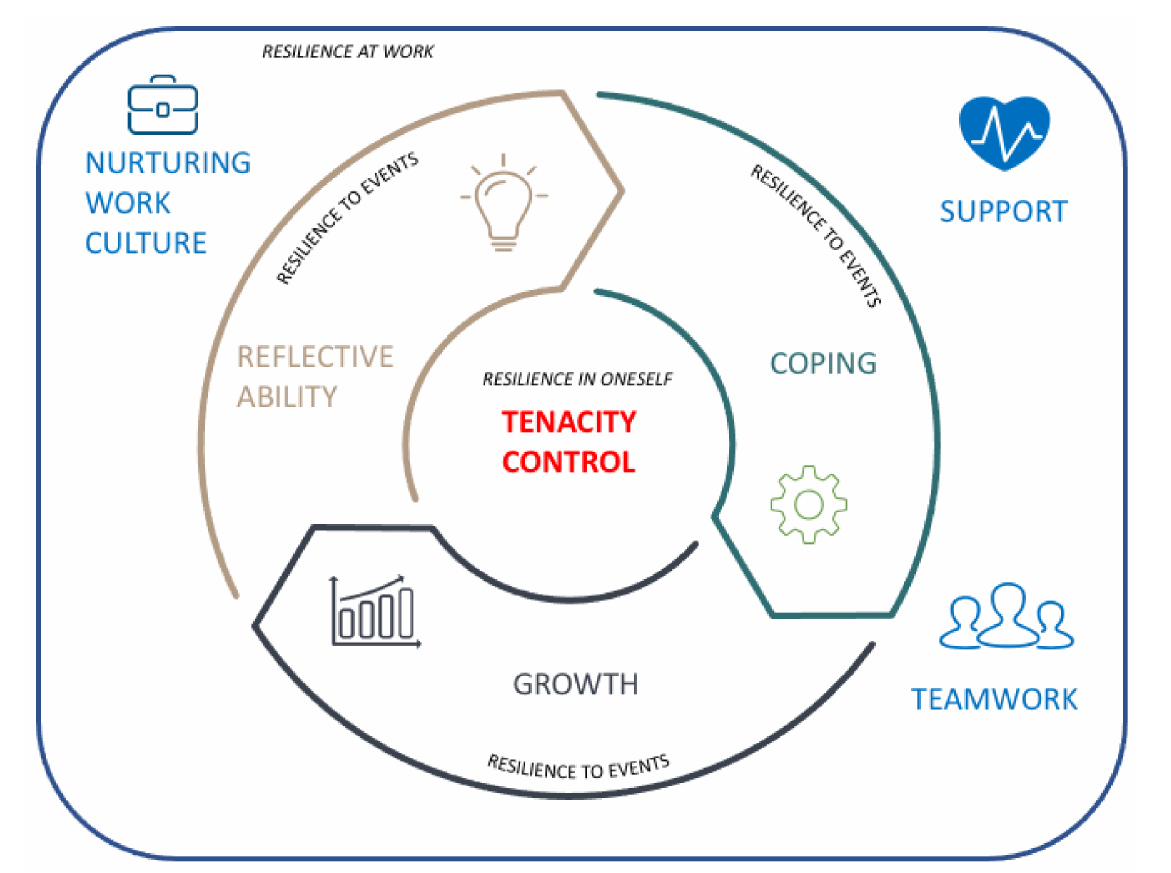
Figure 2. Conceptual model of themes of physician resilience derived from the meta-synthesis performed in this study.